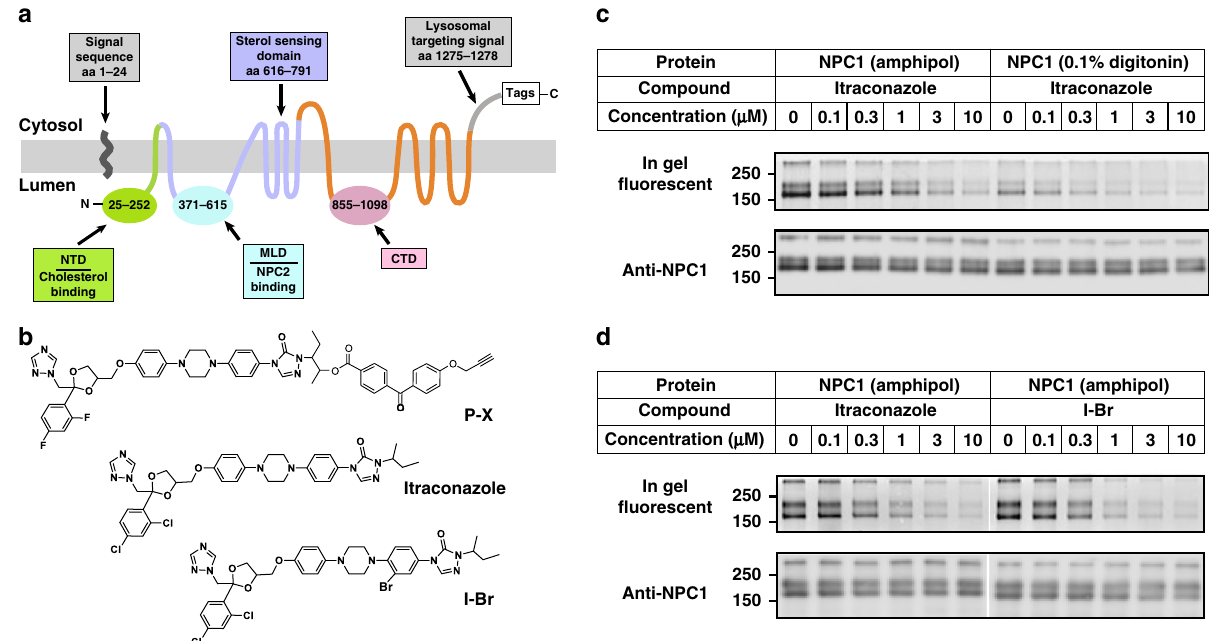
Fig. 1 Identi fi cation of the interaction between NPC1 and itraconazole. a The topology of human NPC1. Functional domains are shown in different colors. NTD, N-terminal domain; MLD, middle lumenal domain; CTD, C-terminal domain. b Chemical structures of compounds used in this study. c , d P-X cross- linking to puri fi ed NPC1. c Detergent interferes with cross-linking of P-X to puri fi ed NPC1. d Br-labeled itraconazole (I-Br) competes with cross-linking of P- X to puri fi ed NPC1 as well as itraconazole. In c , d , the proteins were subjected to fl uorescent labeling using click chemistry, followed by 8% SDS/PAGE and in-gel fl uorescence scanning (Upper) or immunoblotting with anti-NPC1 (Lower). Source data are provided as a Source Data fi